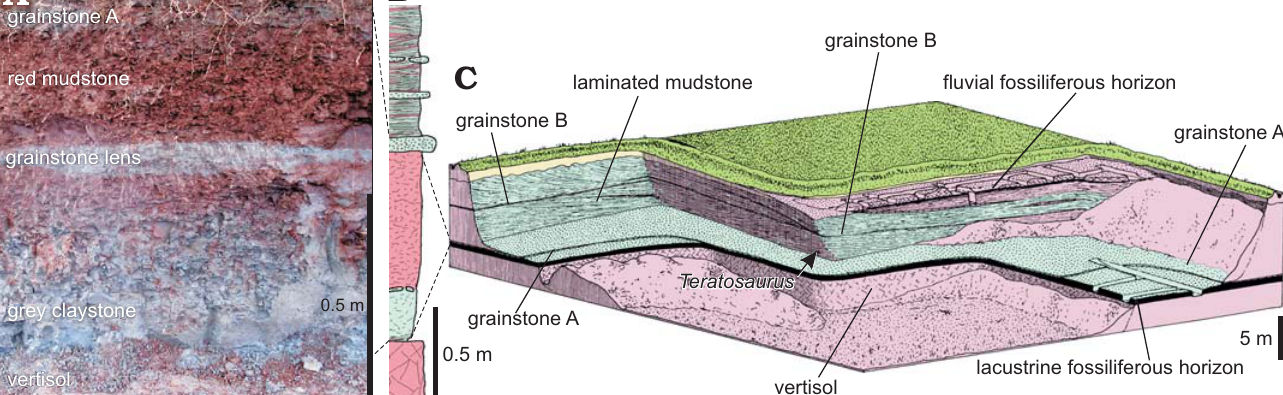
Fig. 1. Krasiejów claypit yielding Ozimek volans gen. et sp. nov. A . Photograph of the quarry wall with exposed fossiliferous lacustrine horizon. B . Rock column of strata of lower Upper Triassic exposed at Krasiejów and position of the lacustrine bed (modified after Dzik et al. 2000). C . Diagrammatic representation of the NW corner of the quarry with location of the lacustrine bed indicated (modified after Dzik